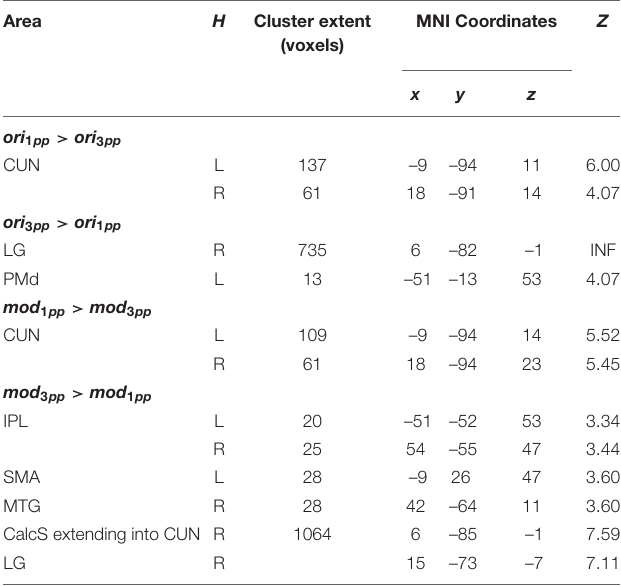
TABLE 2 | Peak activations from second-level whole-brain analyses of perspective effects in episodes.